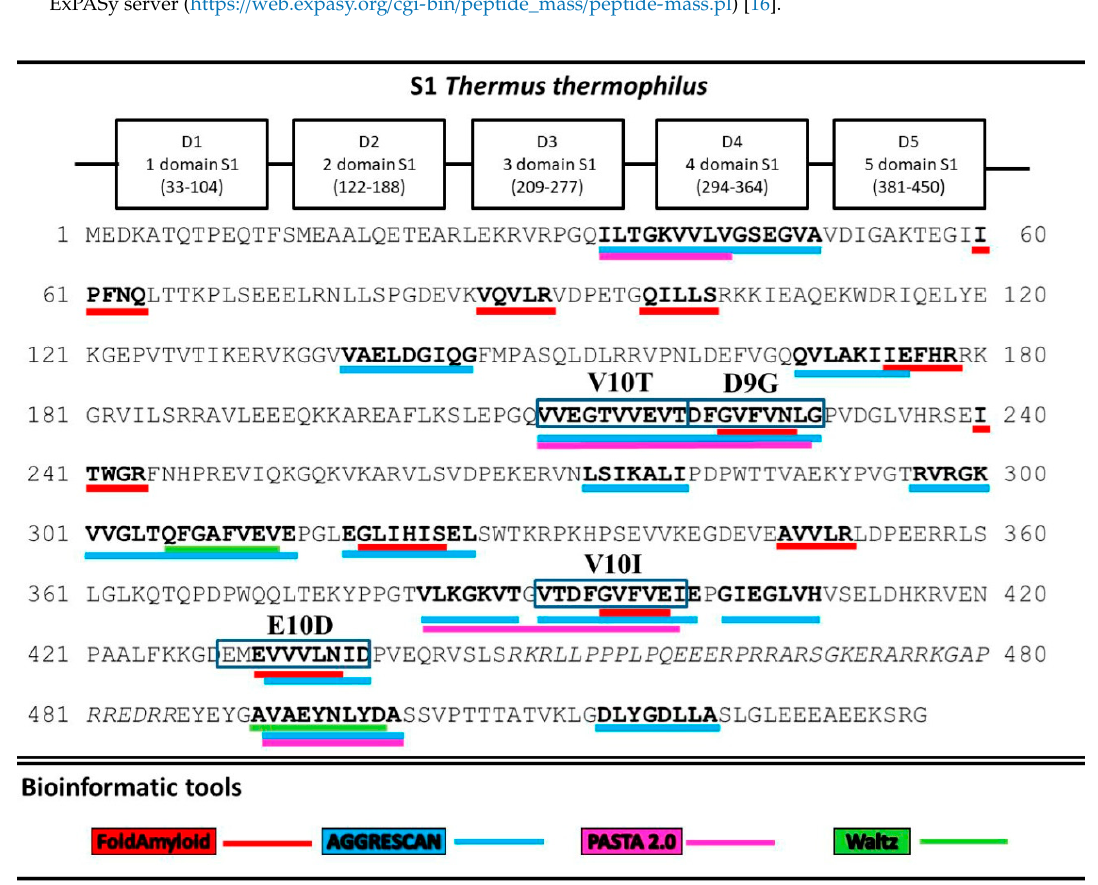
Figure 2. Prediction of amyloidogenic regions prone to aggregation. Amyloidogenic fragments for synthesis are outlined in the rectangles.